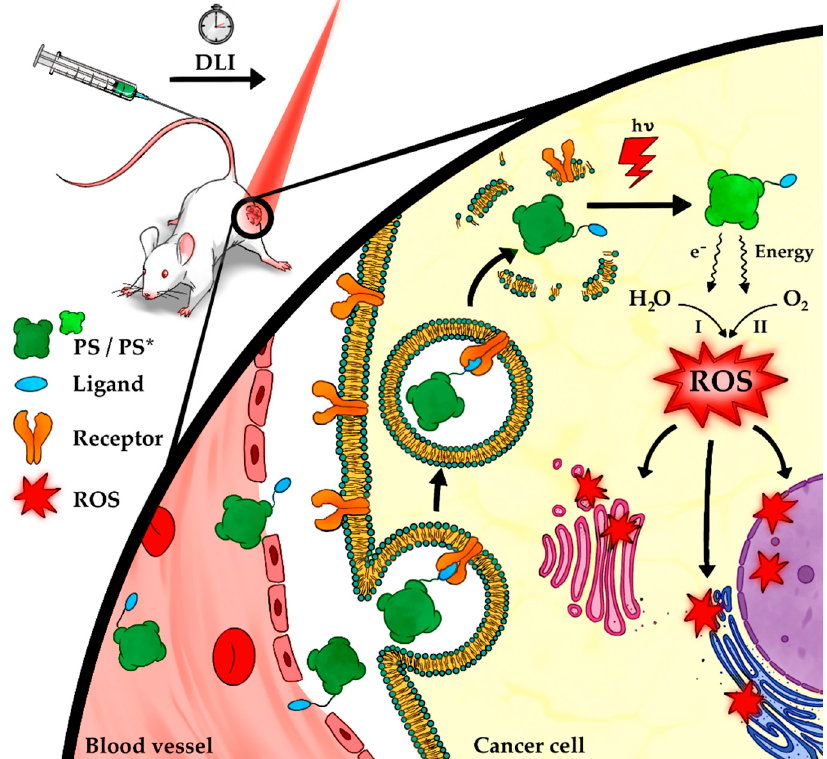
Figure 1. Ligand-targeted strategies may ensure effective delivery of IV-administered photosensitizers (PSs) to cells of the tumor microenvironment. Upon intravenous administration, a ligand-targeted PS is expected to be in circulation for adequate time to allow extravasation through endothelial fenestrations of the angiogenic tumor blood vessels into the tumor mass. Upon tumor accumulation, the targeting moiety attached to the PS is recognized by receptors overexpressed on the surfaces of cancer or other stromal cells, leading to endocytosis-mediated internalization of the PS. When the targeting-ligand and/or drug delivery carrier exhibits fusogenic properties that can destabilize the endocytic vesicles, the PS is released into the cell cytosol with further accumulation in different organelles. However, the PS may remain entrapped at the endocytic compartment until the illumination time. After a certain time (drug-to-light interval, DLI) which typically corresponds to the time that allows the highest tumor accumulation, illumination of tumors is performed with a laser at an appropriate wavelength. Photons are then absorbed by the PS which interact with molecular oxygen in type I and/or II reactions. Local generation of singlet oxygen, 1 O 2 , and/or different reactive oxygen species (ROS) oxidizes biomolecules in their vicinity. Finally, the generated oxidative stress and associated damage culminate in cancer cell death via di ff erent